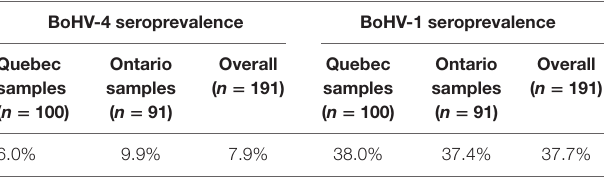
TaBle 1 | Bovine gammaherpesvirus 4 (BoHV-4) and 1 (BoHV-1) seroprevalence in Quebec and Ontario provinces. BohV-4 seroprevalence